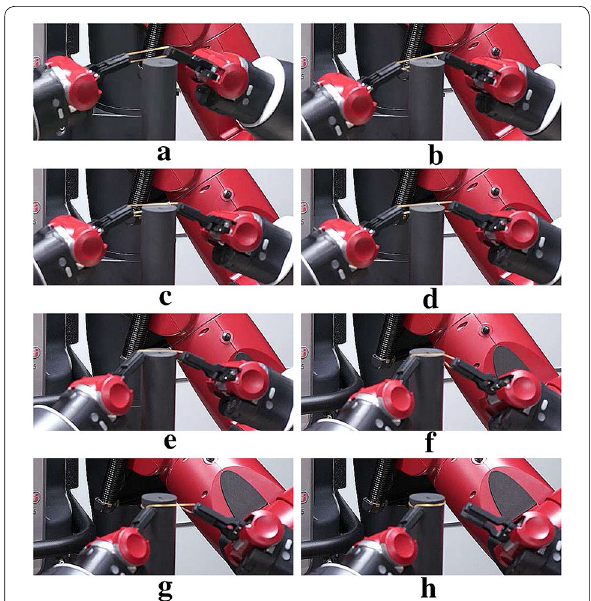
Fig. 8 Snapshots of the assembly experiment using an elastic band (natural rubber) at a initial state, b at right arm key point 2, c between right arm key point 2 and left arm key point 4, d between left arm key point 4 and right arm key point 3, e at right arm key point 4, f between right arm key point 5 and left arm key point 6, g end of the assembly task and h after releasing the elastic band from the left